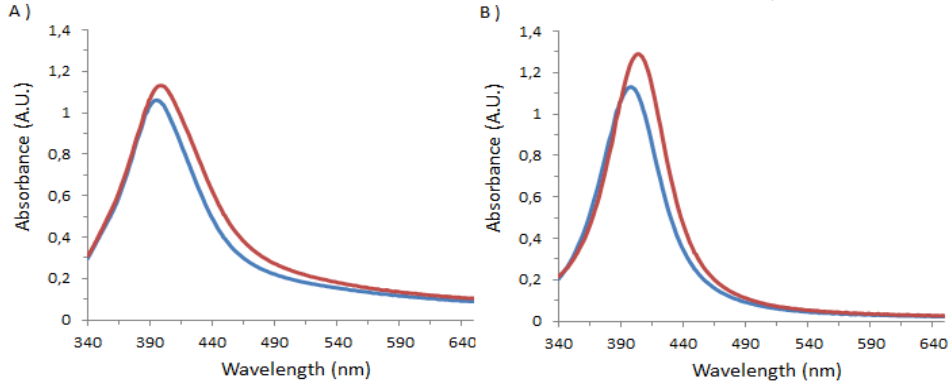
Figure 1. UV-Visible spectra of ( A ) 1 _Ag_NP or ( B ) 2 _Ag_NP mixed with DI water (in blue) or with BSA (in